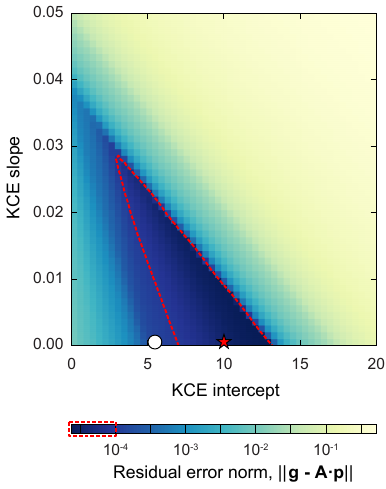
Figure 5. Frequency factor assessment. Model residual error norm using a range of KCE slopes and intercepts for Narayani POC ( β = 5 ◦ Cmin − 1 ). Each pixel represents the best-fit solution to Eqs. (32)–(34) for a given ω as determined by Eq. (35). “Accept- able” fits with a residual error norm ≤ 10 − 4 are contained within the red dotted line. Estimated result using the method of Miura and Maki (1998) for three ramp rates ( β = 2, 5, and 10 ◦ Cmin − 1 ) is plotted as a white circle, while the point corresponding to ω = 10 10 s − 1 (the value chosen for samples in this study) is plotted as a red